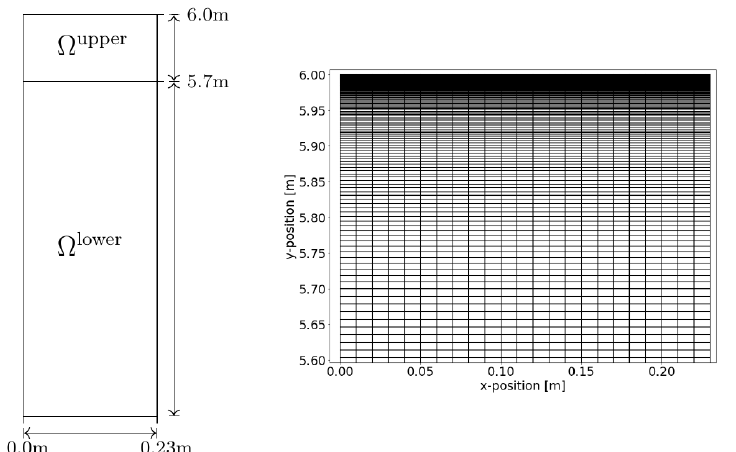
Figure 4. Sketch of the model domain ( Ω ). Regarding the grid, Ω is composed of two subdomains. The lower subdomain Ω lower is discretized with a regular rectangular grid of ˇ n x = 23 cells in the x-direction and ˇ n y = 530 cells in the y-direction. In Ω upper , we applied a grading in the y-direction such that the cell height will be reduced by a factor of 1 with every new cell in the y-direction; see 1.03 the detail on the right. The upper domain had the same number of cells in the x-direction as the lower domain; it was partitioned into 100 cells in the